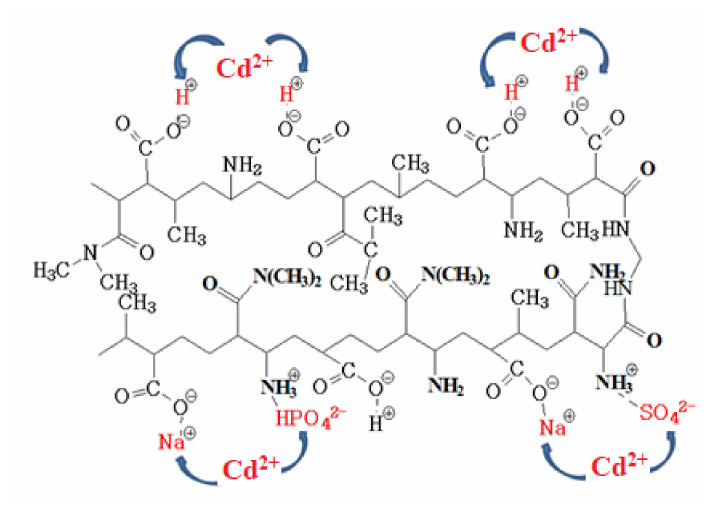
Figure 9. Proposed complexation of Cd 2 + with functional groups of p(MAAc)-DMAAm-AA.